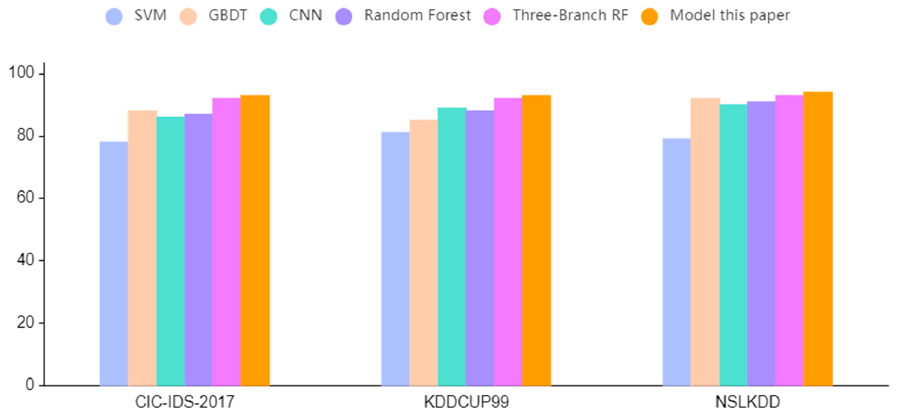
Figure 9. Comparison of F1 score indicators of models on the experimental dataset.